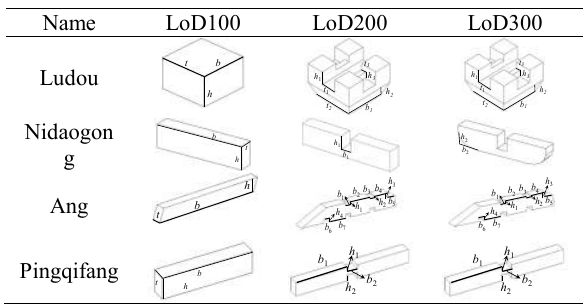
Due to the length limitation, only the schematic diagram of four representatively typical components, including one Dou, Gong, Ang and Fang, are presented in Table 1. Note that the LoD200 and LoD300 models of entire Dou-Gong are composed by the LoD200 and LoD300 models of typical components.